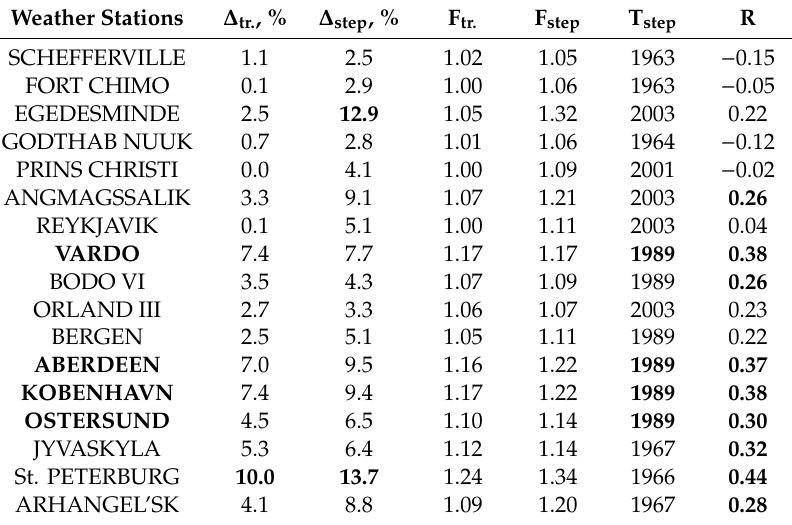
Table 6. The results of the e ffi ciency assessment of non-stationary models for the SAT time series at every weather station in March (1951–2016 period with the size of the time series n = 66). The bold font for ∆ tr. and ∆ step is used when the values are higher than or equal to 10%. The bold font for T step is used for the year 1989 when ∆ step is close to 10%. The bold font for R denotes statistically significant correlation coe ffi cients of linear trends for the whole period. Weather Stations ∆ tr. , % ∆ step , % F tr. F step T step